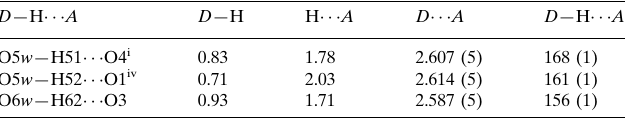
Hydrogen-bond geometry (A˚ , (cid:4)